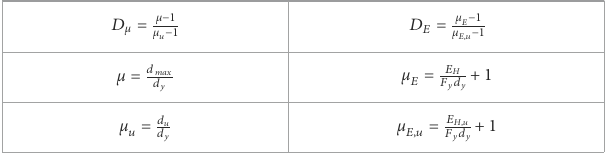
TABLE 1 Formulation of the displacement and hysteretic energy damage indices